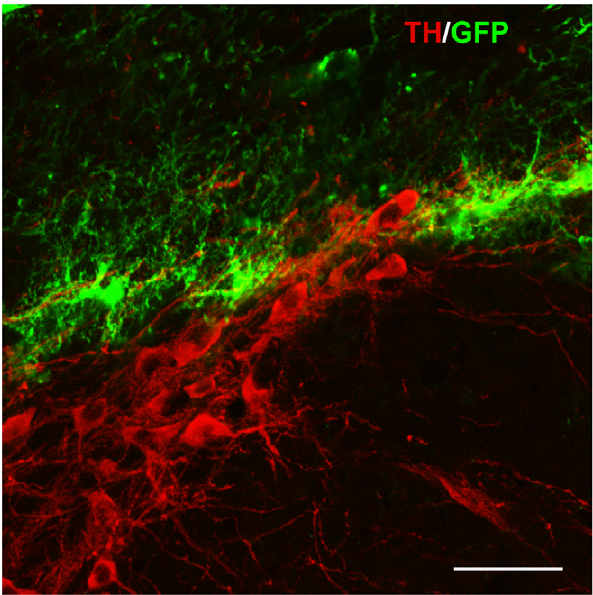
Figure 2. Assessment of Ad5 transduction in the SN invivo . Confocal immunohistochemical assessment of 1e8 vp of Ad5-GFP delivered to the mouse SN (red) shows broad transgene expression in cells of glial morphology (green). The absence of double-labeled cells indicates Ad5 poorly infects neurons of the SNc (section through periphery of the injection site). Stereotactic coordinates: AP=3.1, ML= 2 1.2, DV= 2 4.6. Red = TH–positive neurons, Green = GFP. Bar =50 m m.